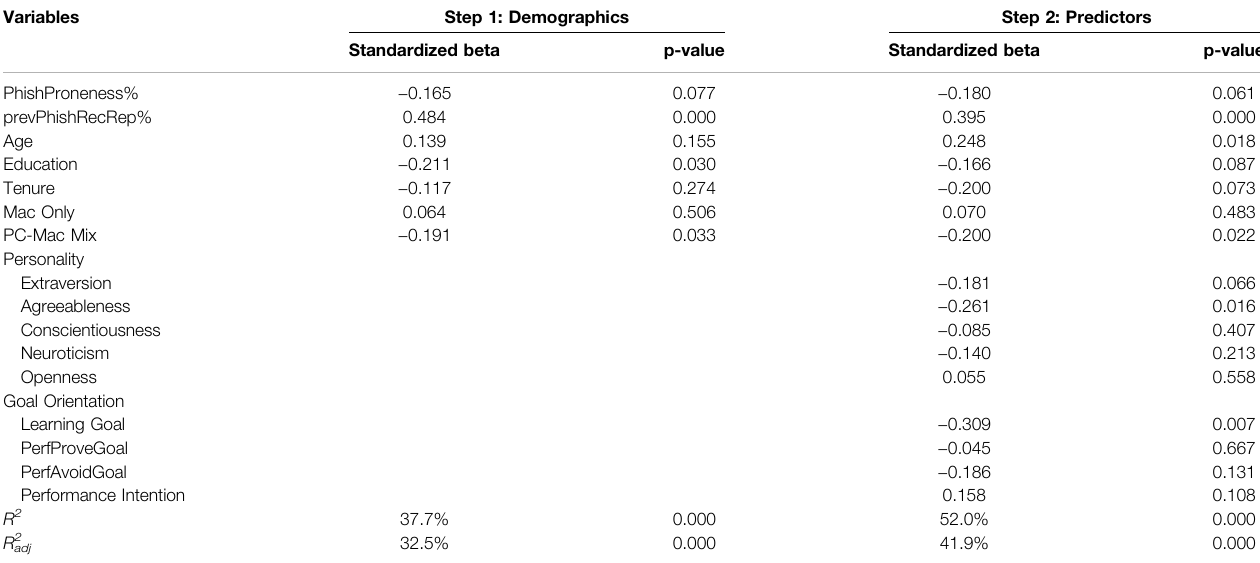
TABLE 3 | Results from hierarchical regression of normalized performance on demographics and predictors. Variables Step 1: Demographics Step 2: